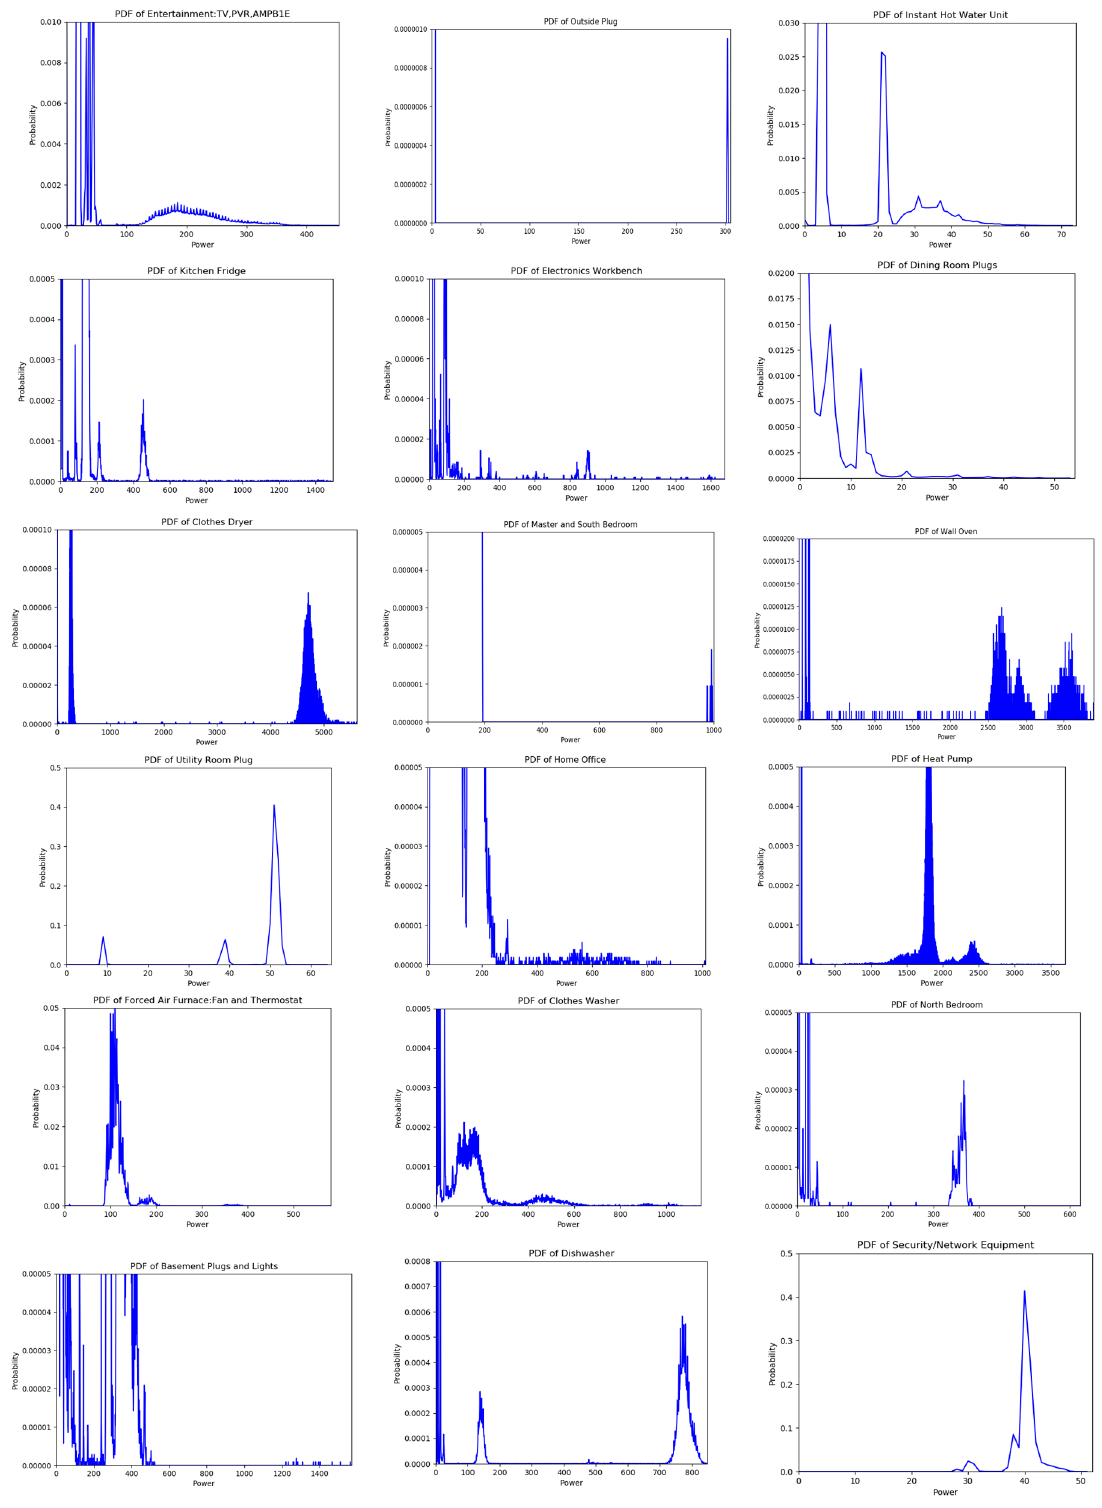
Figure 3. Power probability density function of some appliances in AMPds2.